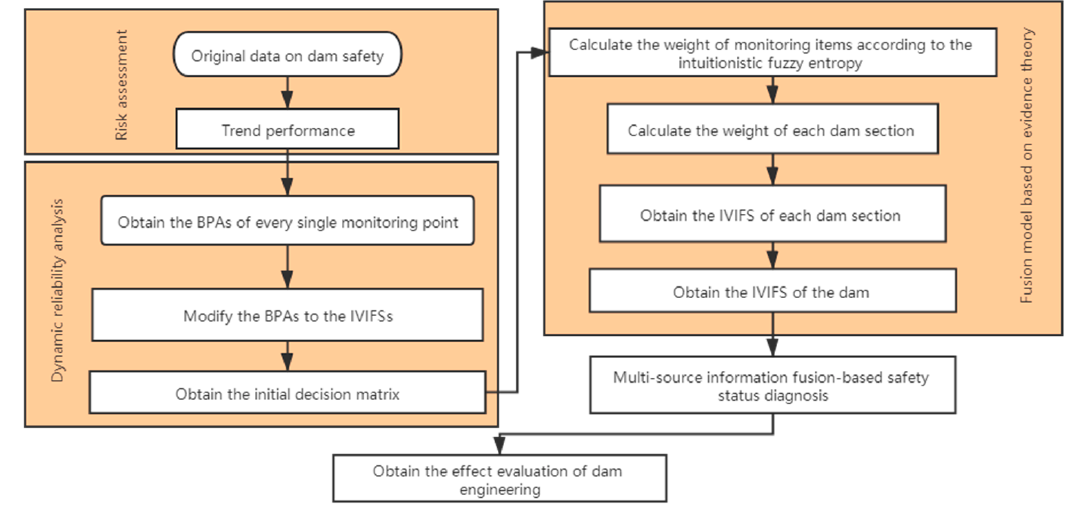
Figure 4. Structure of the proposed dam safety assessment model.